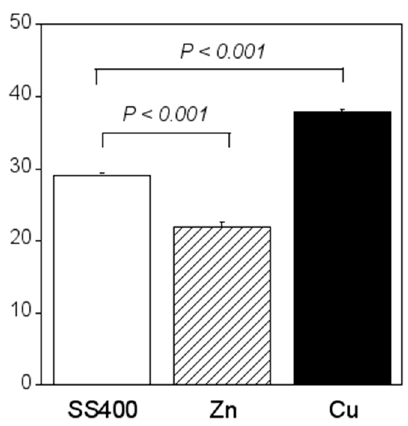
Figure 16. Biofilm quantification of the LBR-immersed coupons. Each column shows the mean of modulus of ( a ∗ ) 2 + ( b ∗ ) 2 + ( 100 − L ∗ ) 2 (n = 5). Zn and Cu mean the Zn-coated coupons and Cu-coated coupons, respectively. Error bars show the standard deviation. Student’s t-test was performed between the SS400 coupons and Zn-coated coupons or SS400 coupons and Cu-coated coupons. P means the p-value.